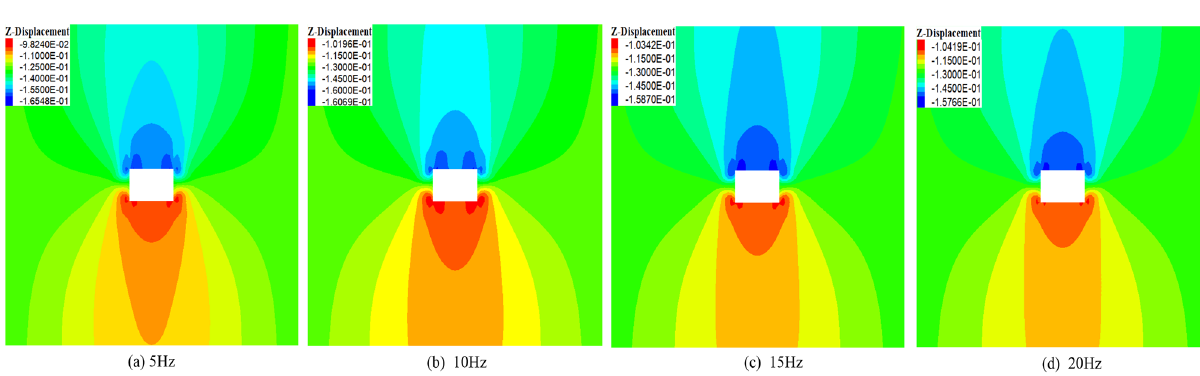
Figure 7. Deformation of surrounding rock under different disturbance